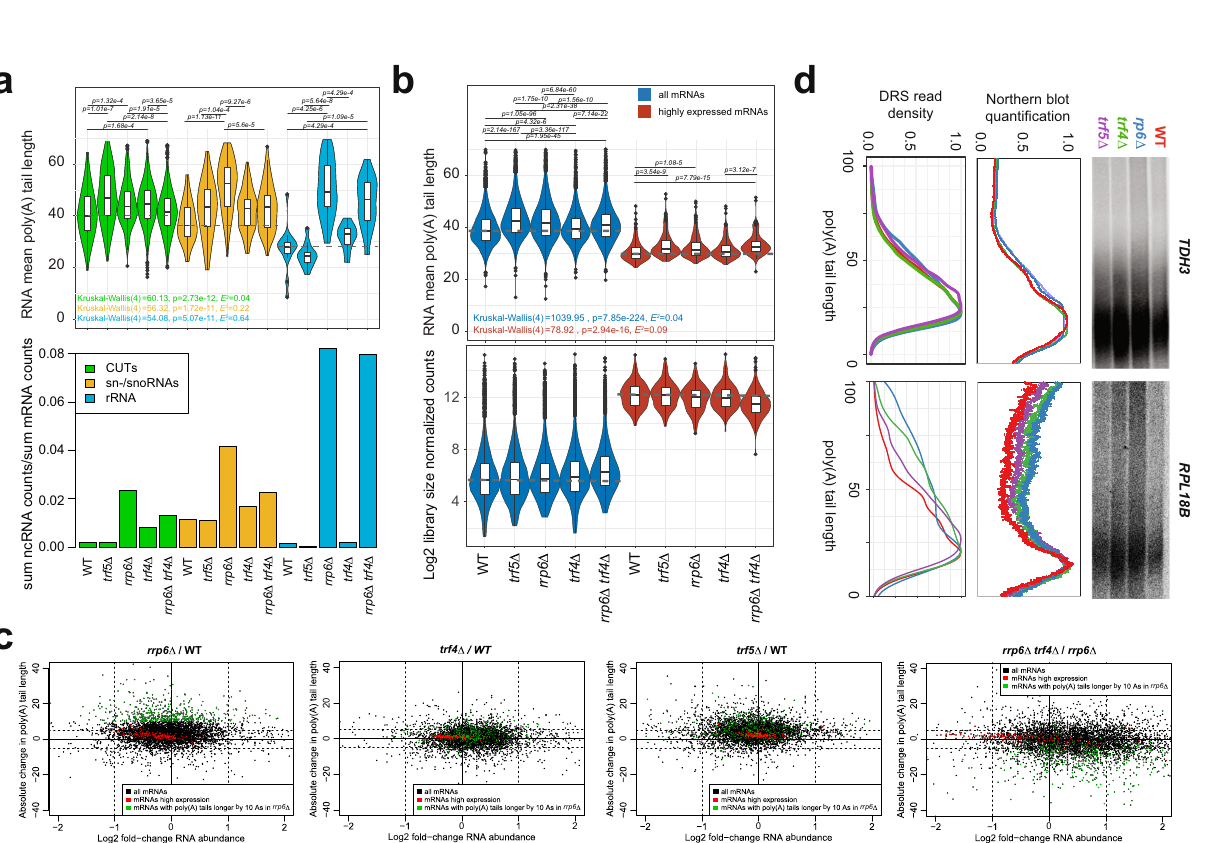
Fig. 2 Pap1 produces poly(A) tails of mostly 50 adenosines with the limit of 200 adenosines, and Trf4 can partially compensate for its depletion. a The top panel shows a beeswarm plot for poly(A) tail length distribution of a collection of heat-induced transcripts in control and Mex67-depleted cells. Means and 99.5% quantile are marked with solid and dashed lines, respectively, for Mex67-AA with or without rapamycin at 38 °C. The bottom panel shows library size normalized counts for those mRNAs. b Empirical cumulative density function plot for poly(A) tail lengths of heat-induced transcripts in control (Mex67-AA -rapamycin: WT 38 °C) and Mex67-depleted cells ( + rapamycin). Dashed lines represent 99.5% quantile for control 38 °C (green) and Mex67-AA 38 °C (red). c Growth of WT, pap1-1 , pap1-1 rrp6 Δ , and pap1-1 trf4 Δ strains. Equal numbers of cells of each strain were spotted on YPDA plates in tenfold serial dilutions and grown for 3 days at 24 or 28.5 °C. d Violin plot of mean mRNA poly(A) tail lengths (top) and mRNA abundance (bottom) of all (blue series) and highly expressed mRNAs (red series n = 184) for WT ( n = 5079), pap1-1 ( n = 5161), pap1-1 rrp6 Δ ( n = 5054), and pap1-1 trf4 Δ ( n = 5770) strains. For the upper panel, Kruskal – Wallis test P value and Holm-corrected P values for two-sided Dunn pairwise test are shown. Dashed gray lines show the mean values for WT strain to ease visual comparison. Box plots show median value (solid bold line) and 1st and 3rd quartiles, whiskers represent 1.5 × IQR (interquartile range). Outliers are marked as black points. e – g Scatterplots of the relationship between log2 fold change in mRNA abundance ( y axis) and absolute change in mean mRNA poly(A) tail for pap1-1 ( e ), pap1-1 rrp6 Δ ( f ), and pap1-1 trf4 Δ ( g ) cells ( x axis), compared with WT. Dashed lines mark a twofold change in expression level and a 5-adenosine change of mean poly(A) tail length. h Poly(A) tail length distribution of TDH3 and TDH1 in pap1-1 mutant cells (upper panel) and relative abundance changes for each condition (bottom). The number of DRS reads for each condition is shown for each transcript. Red dashed lines show the mean for each condition. Pearson ’ s correlation coef fi cients are indicated on each scatterplot.